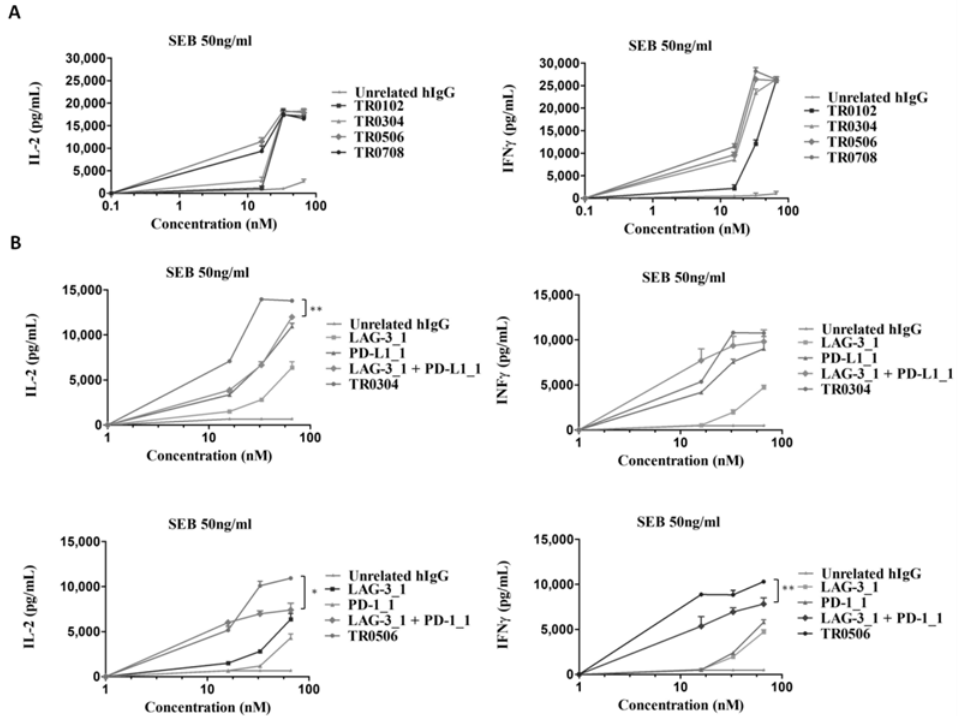
Figure 6. Effects of the tribodies on hPBMC activation and secretion of cytokines. The levels of IL-2 and IFN γ were measured by cytokine secretion assays on supernatants of hPBMCs stimulated with SEB (50 ng/mL) and treated with the indicated tribodies ( A ) or with TR0304 and TR0506 in comparison with their parental mAbs or combinations thereof ( B ) at the same concentrations. Cytokine concentration values are expressed in pg/mL. An unrelated antibody was used as a negative control. The values are reported as the mean of at least three determinations obtained in three independent experiments. Error bars depict means ± SD. p -value: ** p < 0.01; * p <